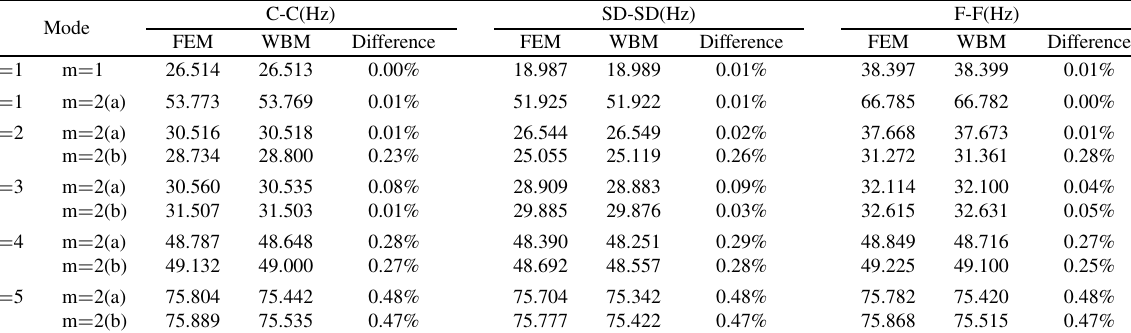
Table 4 Comparison of natural frequencies of model M1 calculated by FEM and WBM